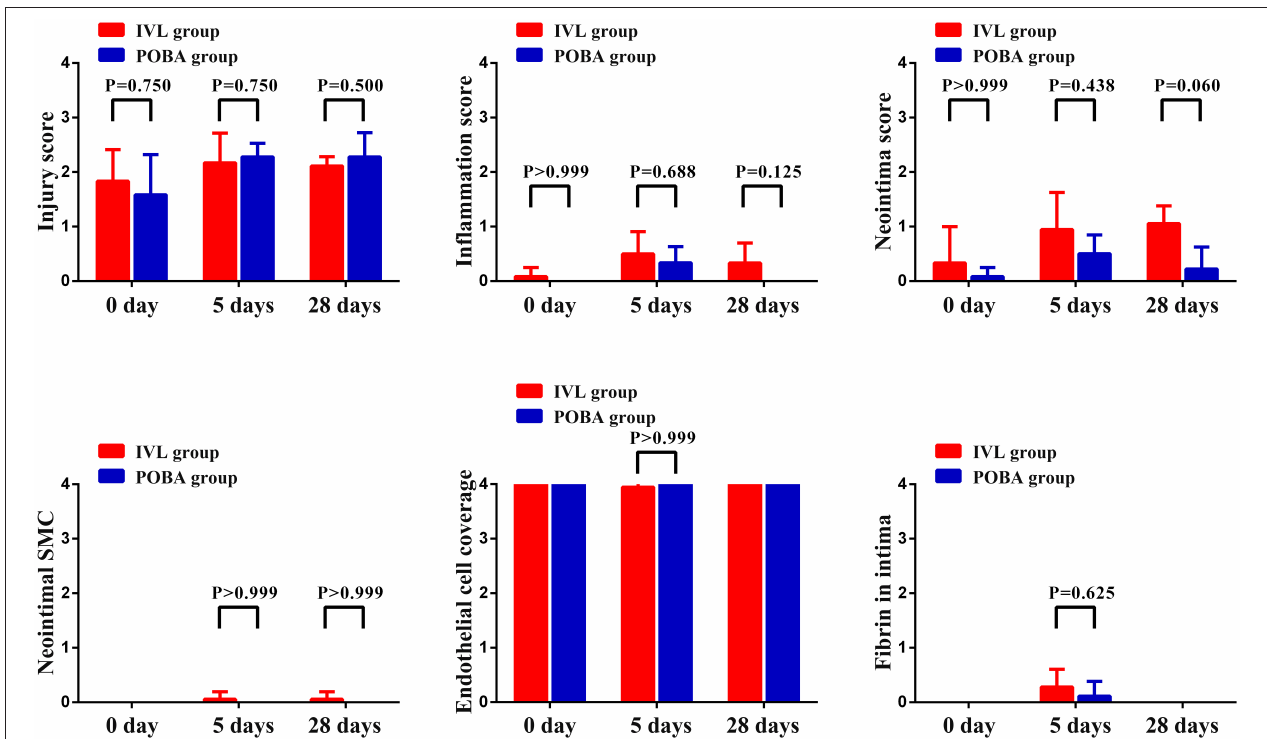
FIGURE 6 | Histomorphological analyses of local vascular tissue responses in IVL and POBA groups. IVL, intravascular lithotripsy; POBA, plain old balloon